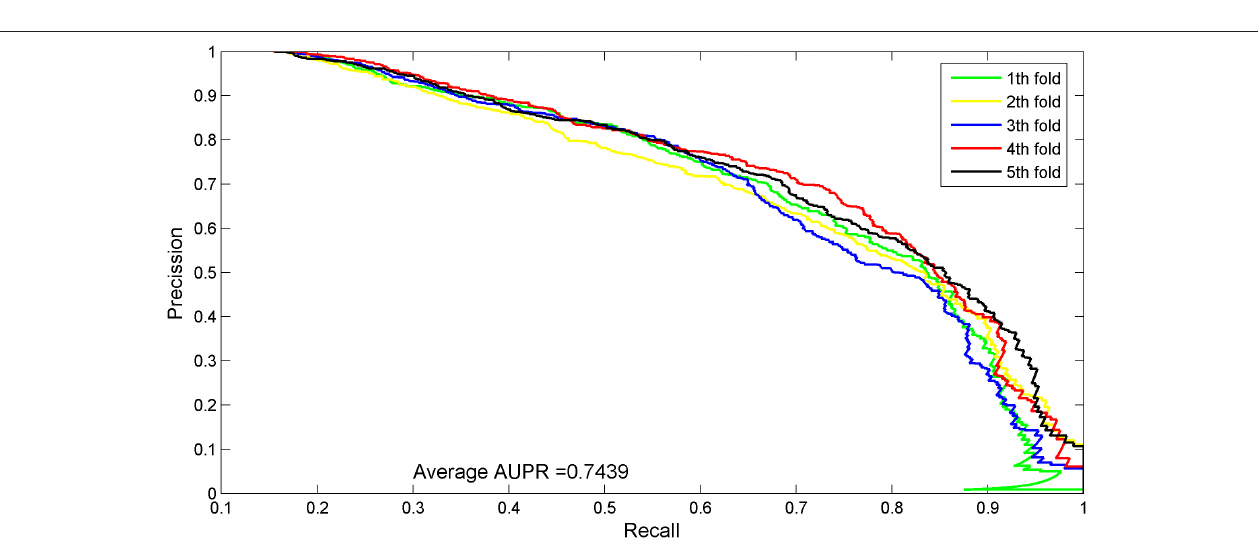
FIGURE 3 | AUPR curves for five-fold cross-validation tests of the benchmark